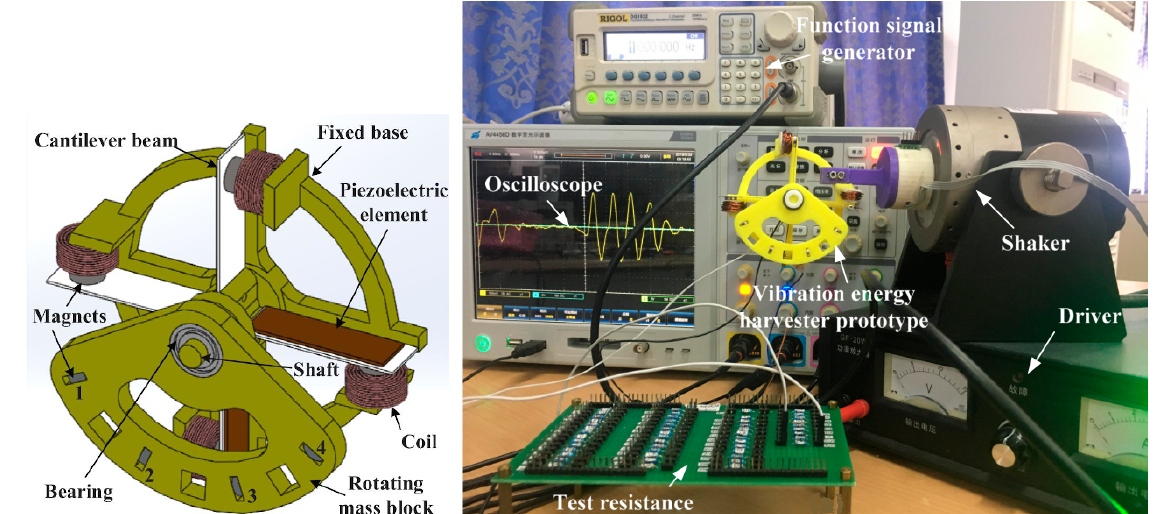
Figure 7. ( left ) Structure of the hybrid piezo-electromagnetic multi-directionalharvester [67], ( right ) experimental setup with printed harvester [67].